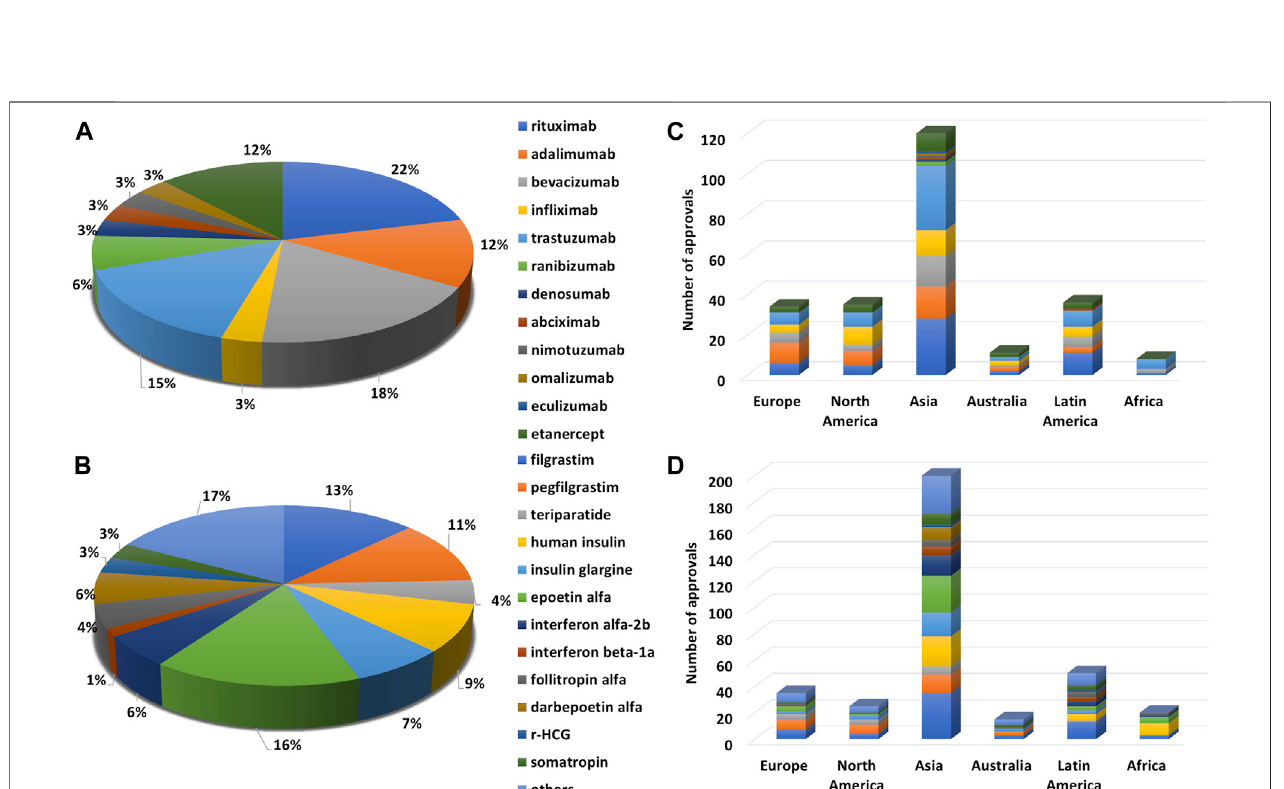
Frontiers in Bioengineering and Biotechnology |